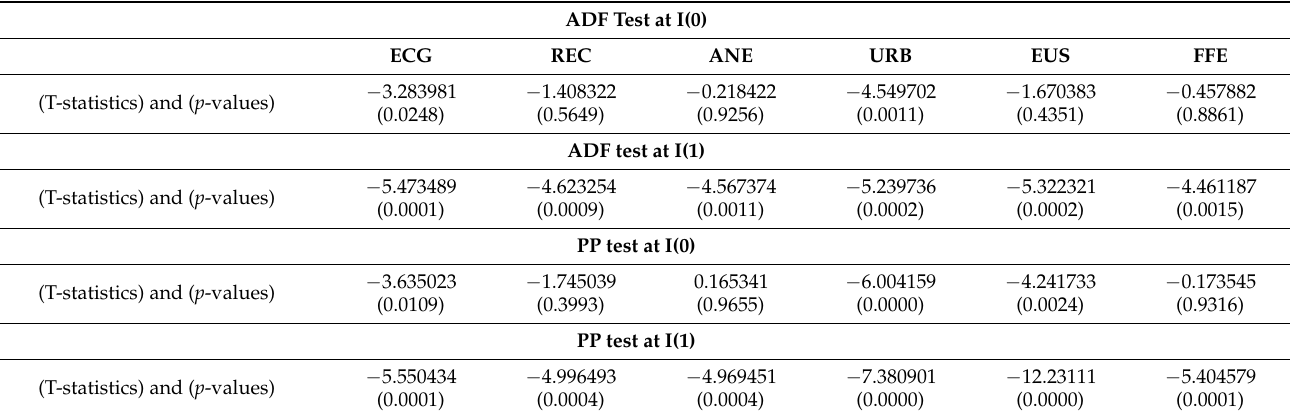
Table 5. Unit root testing for the